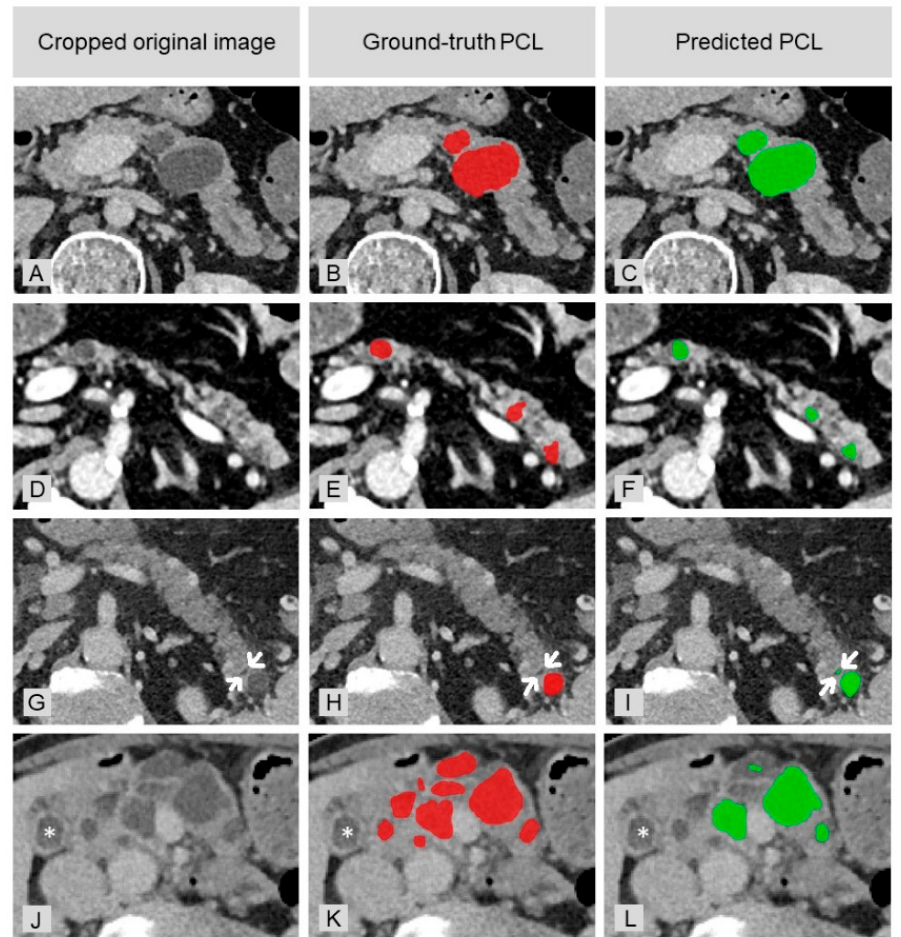
Figure 3. Examples of detected PCLs and manually segmented cysts of the GT in comparison with the original images: ( A – C ) true positive detection of large cysts; ( D – F ) true positive detection of smaller cysts; ( G – I ) false-positive finding (small fat interdigitation; marked with arrows); and ( J – L ) failure at detecting multiple cysts. The star indicates the gallblad- der.